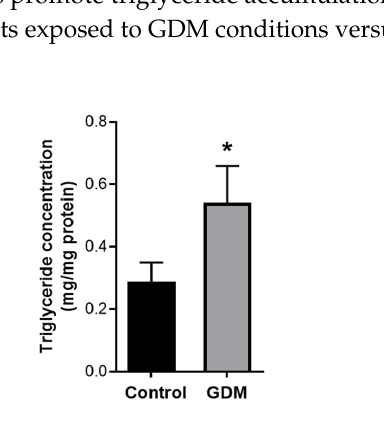
Figure 3. Changes in triglyceride content in the trophoblasts exposed to control and GDM conditions. Primary human trophoblasts were cultured in standard conditions or with medium containing 25- mmol/L glucose and 10 −7 -mol/L insulin for 72 h. The intracellular triglyceride level in the cells was quantified with a colorimetric assay. Values are expressed as means ± SD of three independent experiments. * p < 0.05 vs.